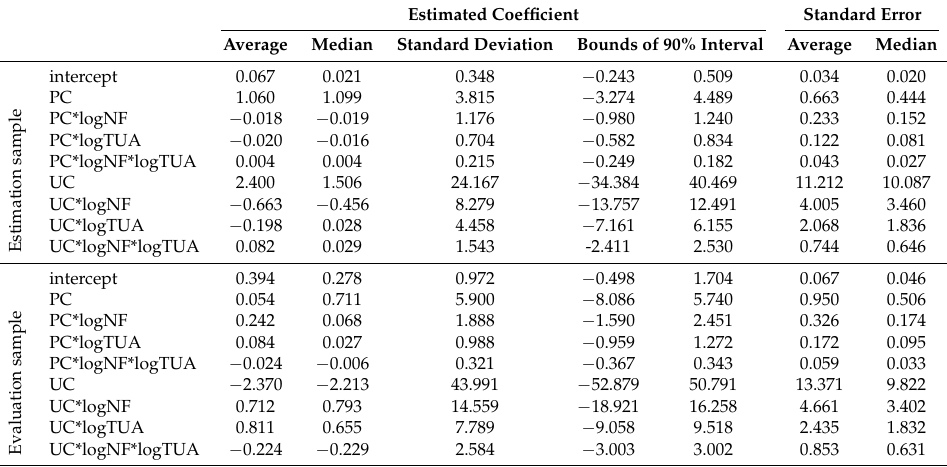
Table 9. A summary of results of the regression of the actual earnings on predictable and unpredictable component variables: Actual = α + β PCV + γ UCV . PCV not only includes the predictable component itself, but also multiplications of the predictable component with logNF, the logarithm of the number of forecasts on which Average Forecast is based at that moment, and, with logTUA, the logarithm of the number of days until the announcement. In a similar way, UCV is based on the unpredictable component and multiplications of unpredictable component with logNF and logTUA. We performed these regressions for each firm separately (of the 316 firms) but pooled the results of all 18,338 forecasters. The total number of observations in the regressions across all firms is 146,319 in the estimation sample and 126,651 in the evaluation sample. We show as summary of the results several statistics (average, median, standard deviation, and 90% interval) on the estimated parameters and also the average and median of the standard error of the parameters.